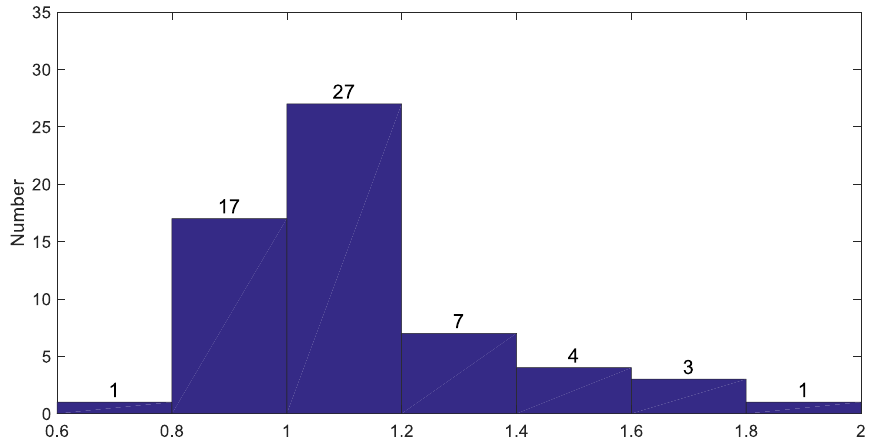
Figure 12. Histogram of the difference of the start/end elevation angle from a rising/setting occultation event between closed-loop and OL. Because the top height of the mountain is about 2 km, the minimum elevation angle value is generally about −3° in OL mode, and the difference is mainly concentrated between 0.8° and 1.2°.